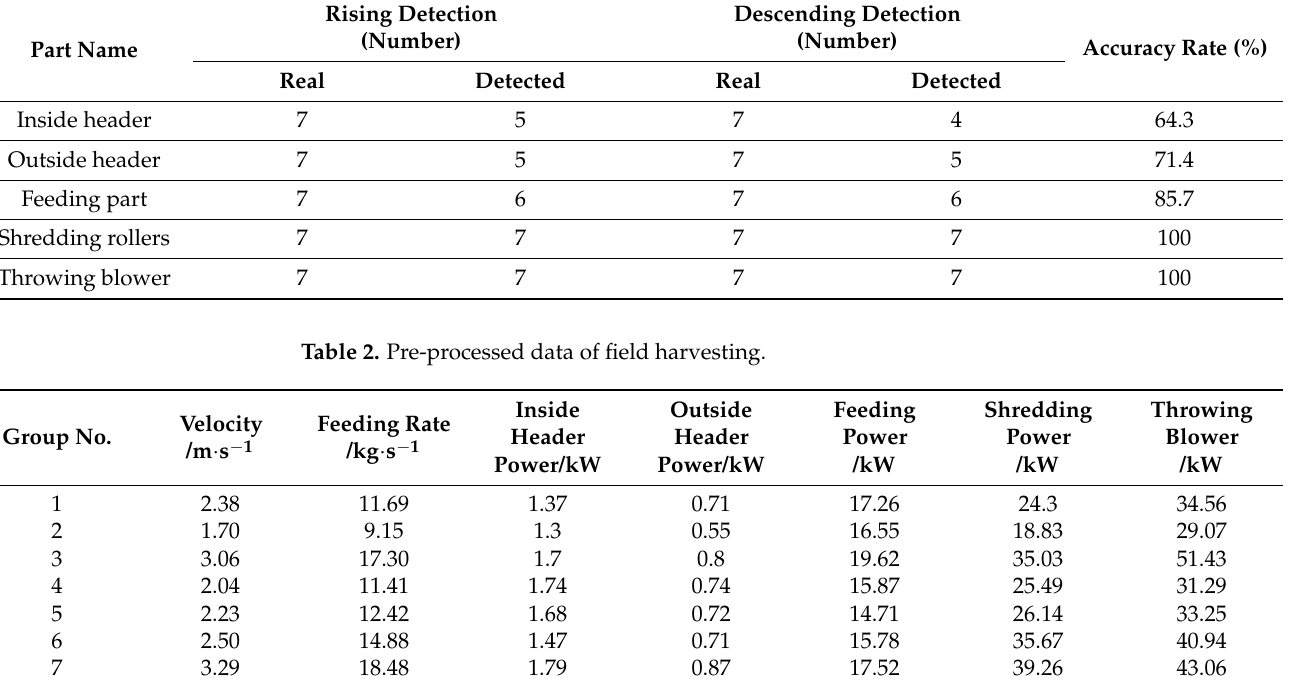
Figure 6. Results of data filtering; ( A ) The rising boundary of the shredding data; ( B ) The descending boundary of the shredding data; ( C ) The rising boundary of the blowing data; ( D ) The descending boundary of the blowing data. Table 1. Results of boundary detection for data filtering.